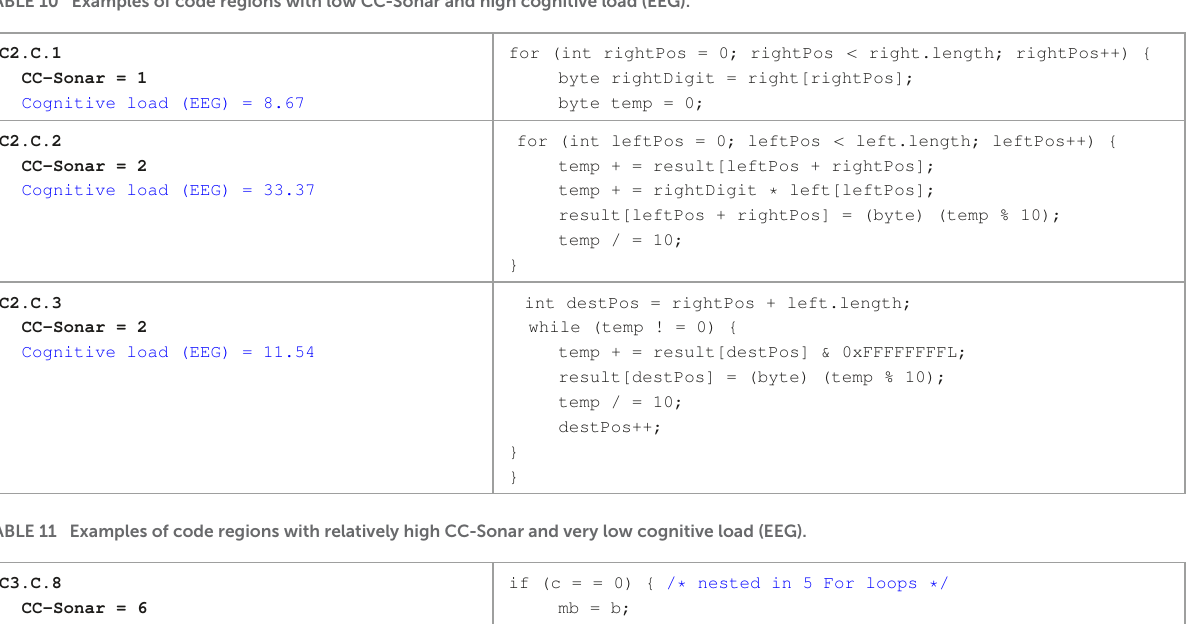
TABLE 10 Examples of code regions with low CC-Sonar and high cognitive load (EEG).